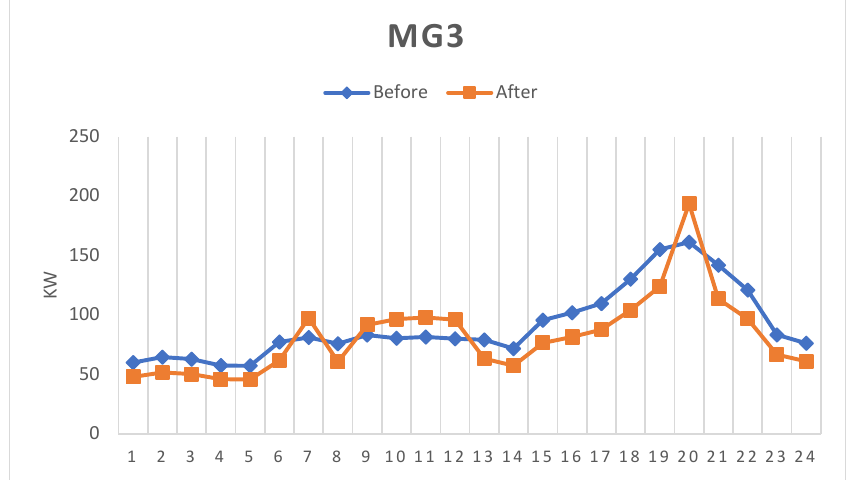
Figure 10. Consumption variations in microgrid 3: model 1. The amount of power bought from and sold to the microgrid cluster, and the amount of power produced by each microgrid is determined by the game in the microgrid layer based on the prices set by the upstream network. The consumption power is obtained from the consumer layer, while the microgrid cannot change this consumption. Each microgrid is trying to produce the maximum renewable energy to increase its profits due to the high production costs of gas units. Figures 11–13 show the variation in the production power of each microgrid and the power bought and sold with the microgrid cluster. These figures show that each microgrid uses the maximum capacity of renewable generation to increase its profit in the hours when it can use them. Additionally, during peak hours for energy supply, consumers buy energy from the upstream network.